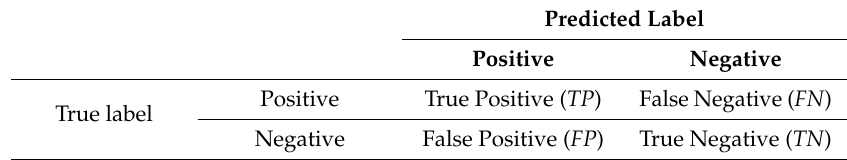
Figure 10. Receiver Operating Characteristic Curve ( ROC) and AUC of SVC using 10-fold cross- validation.